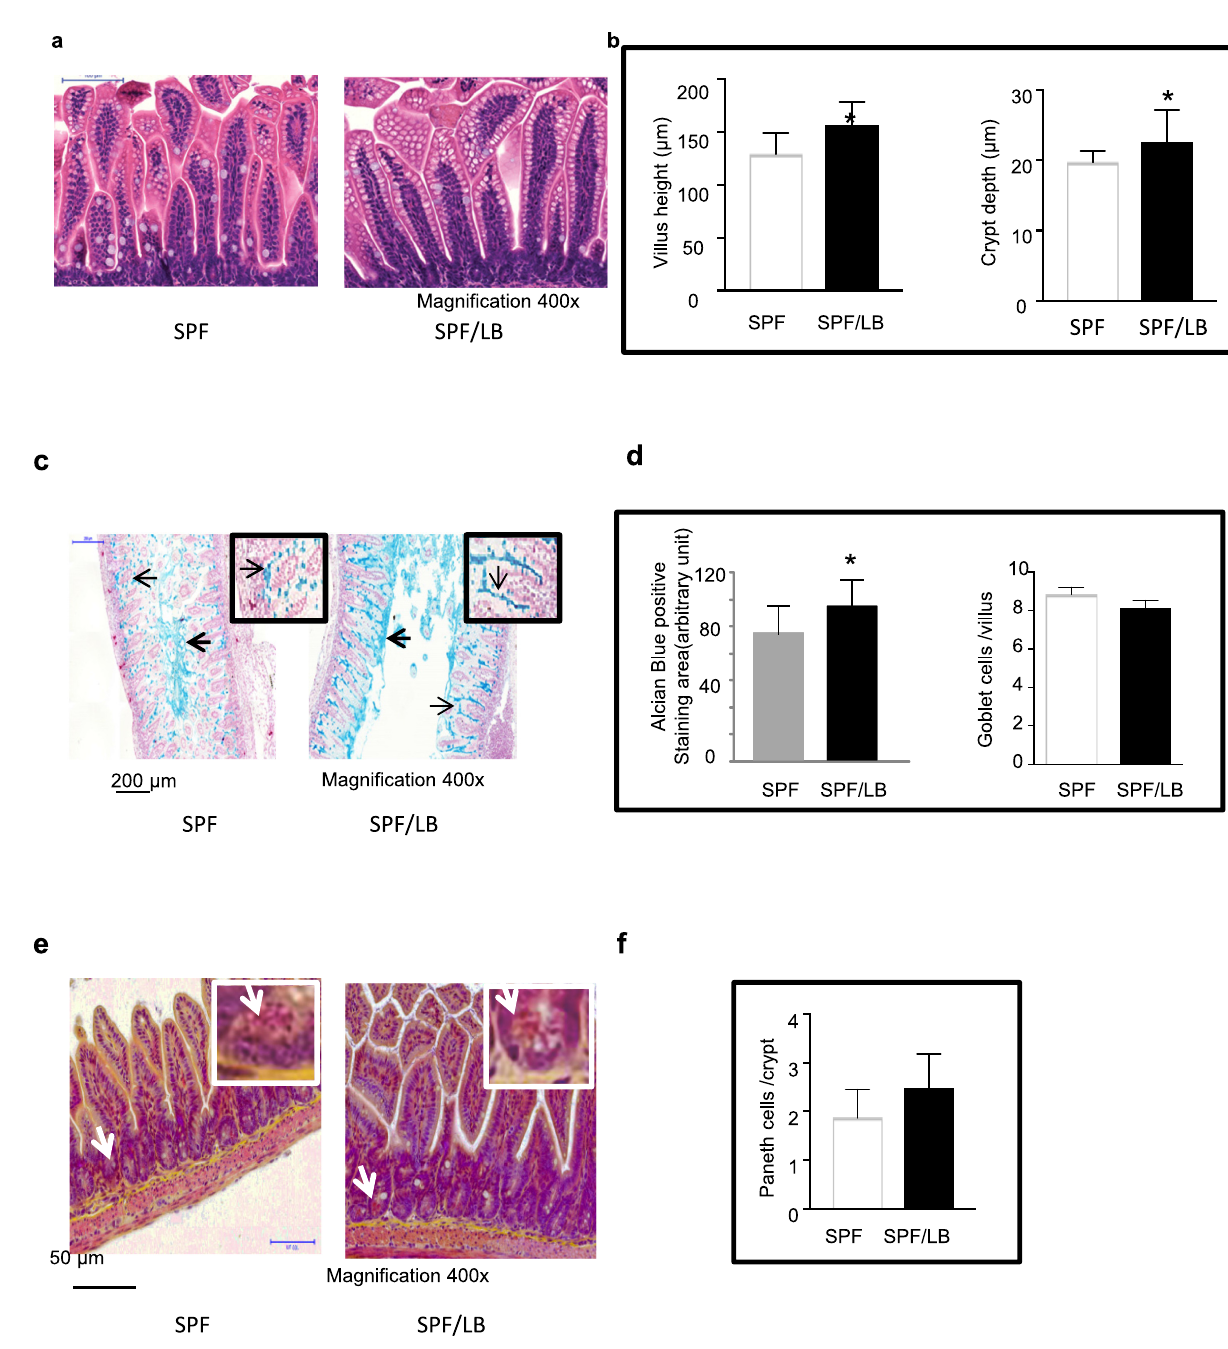
Fig 1. Maternal LB effects on intestinal development in 2-wk-old mouse pups. a) H&E staining of SPF and SPF/LB 2-wk-old mouse pup ileal tissue. b) Mean ileal villus height and mean crypt depth (SPF n = 8; SPF/LB n = 7). Results are presented as mean ± SEM. The student’s t-test was used to compare the groups. � p < 0.05. c,d) Alcian blue staining of mucus on ileal apical surface are presented. The total alcian blue stained areas were measured and quantification of mucus areas are presented as (mean ± SEM, n = 4). The student’s t-test was used to compare groups. � p < 0.05, Bar = 200 μ m. Alcian blue positive goblet cells were counted in 20 villi/sections and presented as (mean ± SEM, n = 4). The insets represent goblet cells in the ileal villi. e,f) Phloxine B-tartrazine staining of intestinal Paneth cells in the crypts of ileal sections. Mean Paneth cells from 20 crypts/section were counted and presented as (mean ± SEM, n = 3/group). The inset represents typical Phloxine B-tartrazine staining positive Paneth granules.